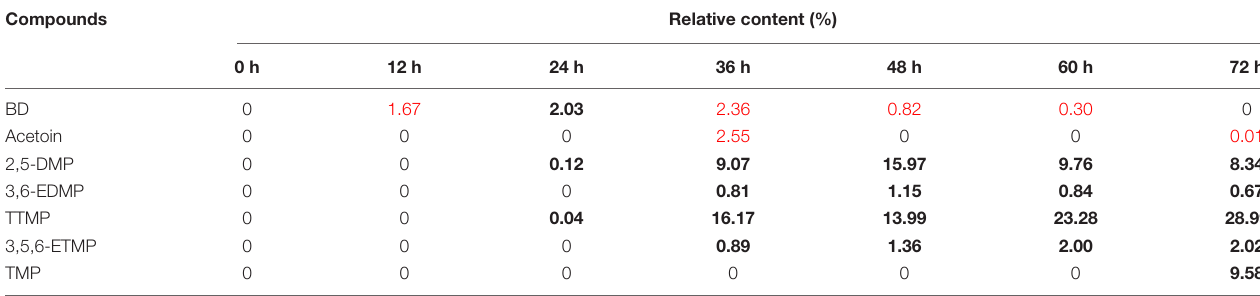
TABLE 6 | Changes in 2,3-butanediol, acetoin, and alkylpyrazine in the non-post fermented Shuidouchi. Compounds Relative content